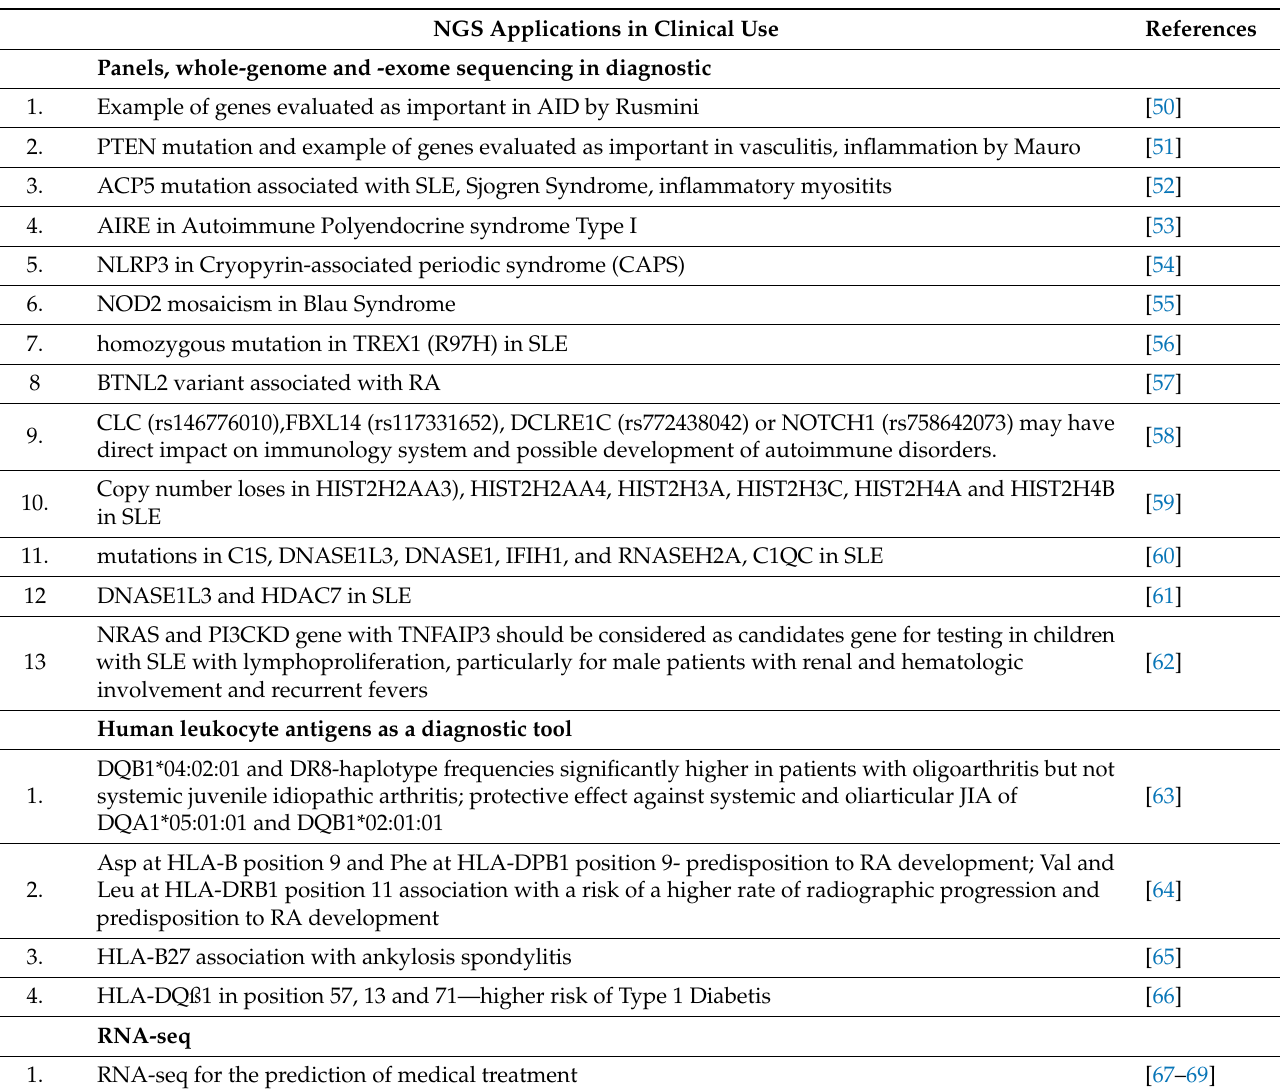
Table 2. Summary of the clinical NGS applications described in the review. NGS Applications in Clinical